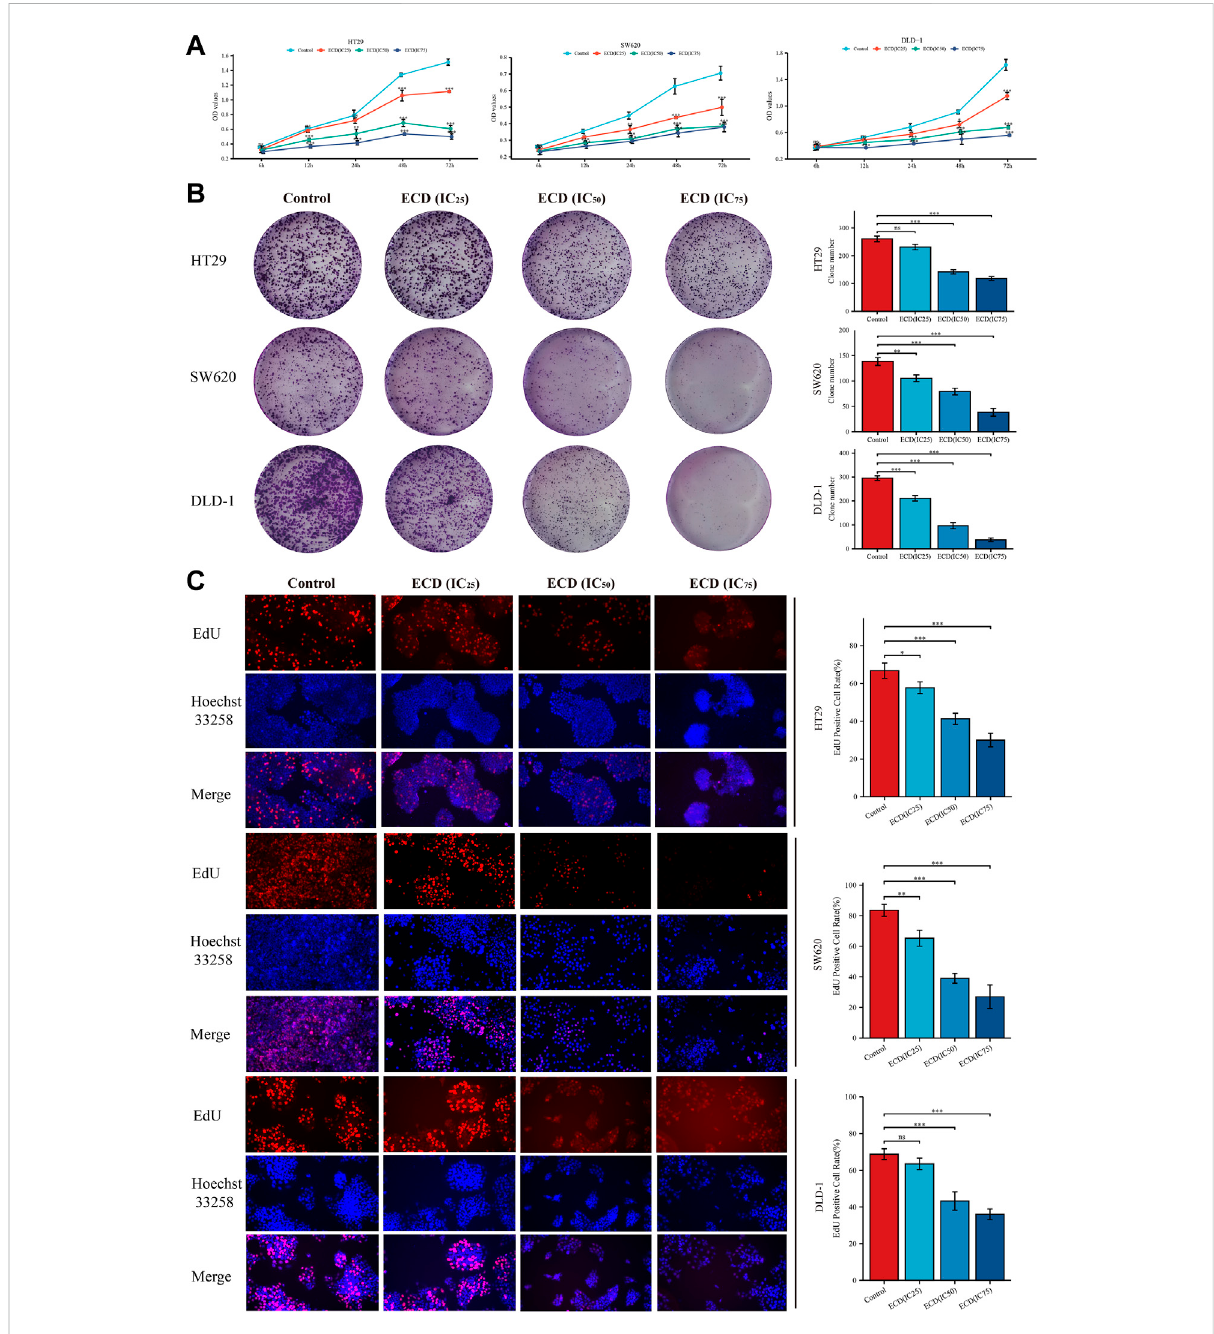
FIGURE 7 ECD inhibited theproliferation of CRC cell lines. (A) Cell Counting Kit-8 (CCK-8)analyses of HT29, SW620, and DLD-1 cell lines after treatment withdifferentworkingconcentrations(IC 25 ,IC 50 ,andIC 75 )ofECDfor6,12,24,48,and72 h( n =3pergroup). (B) ColonyformationanalysesofHT29, SW620, and DLD-1 cell lines cultured with different working concentrations (IC 25 , IC 50 , and IC 75 ) of ECD for 48 h ( n = 3 per group). (C) EdU assays of HT29,SW620, andDLD-1celllinestreatedwithdifferentworkingconcentrations(IC 25 ,IC 50 ,andIC 75 )ofECDfor48 h(×200)( n =3pergroup). ns P > 0.05, * p < 0.05, ** p < 0.01, *** p <